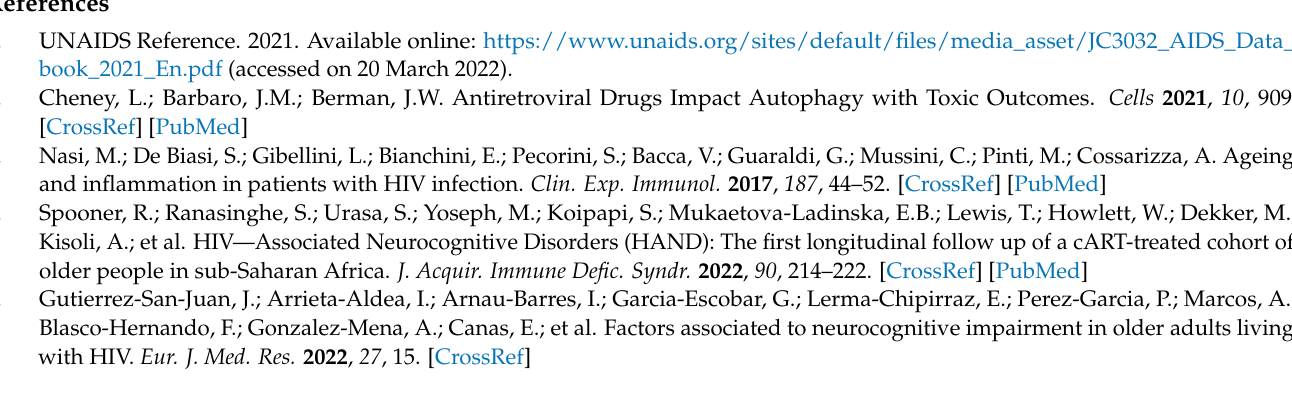
Figure S2: Methamphetamine-induced changes in autophagy/lysosomal components in HIV in- fected macrophages; Figure S3: Determination of mitochondrial membrane potential by JC-1 dye fluorometric plate reader assay; Figure S4: Reactive oxygen species (ROS) levels in uninfected MDM; Figure S5: Inflammasome-mediated IL-1 β release from HIV-infected macrophages; Figure S6: LC3II and p62 Western blot data in uninfected